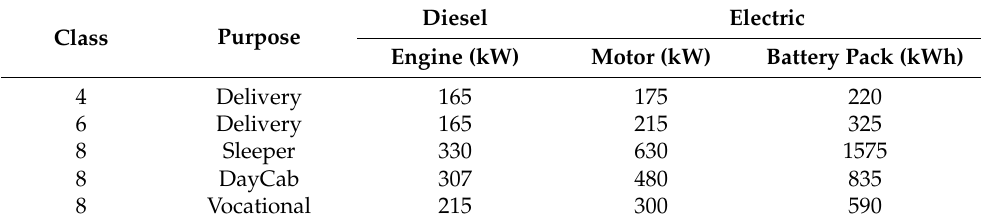
Table 2. Component size summary for comparable conventional and electric